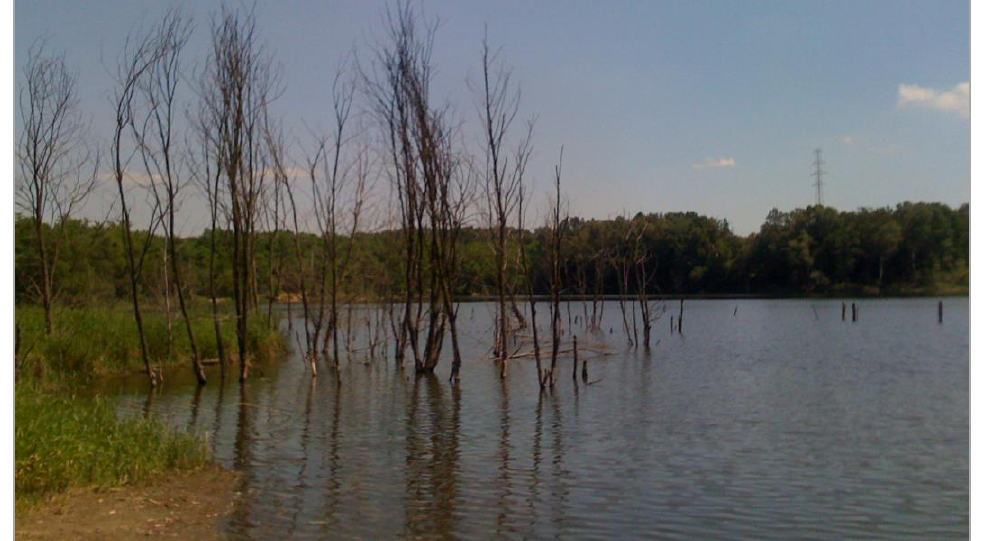
Fig. 6. Subsidence depression in Jastrzębie Zdrój ( J. Pełka-Gościniak, June 2010